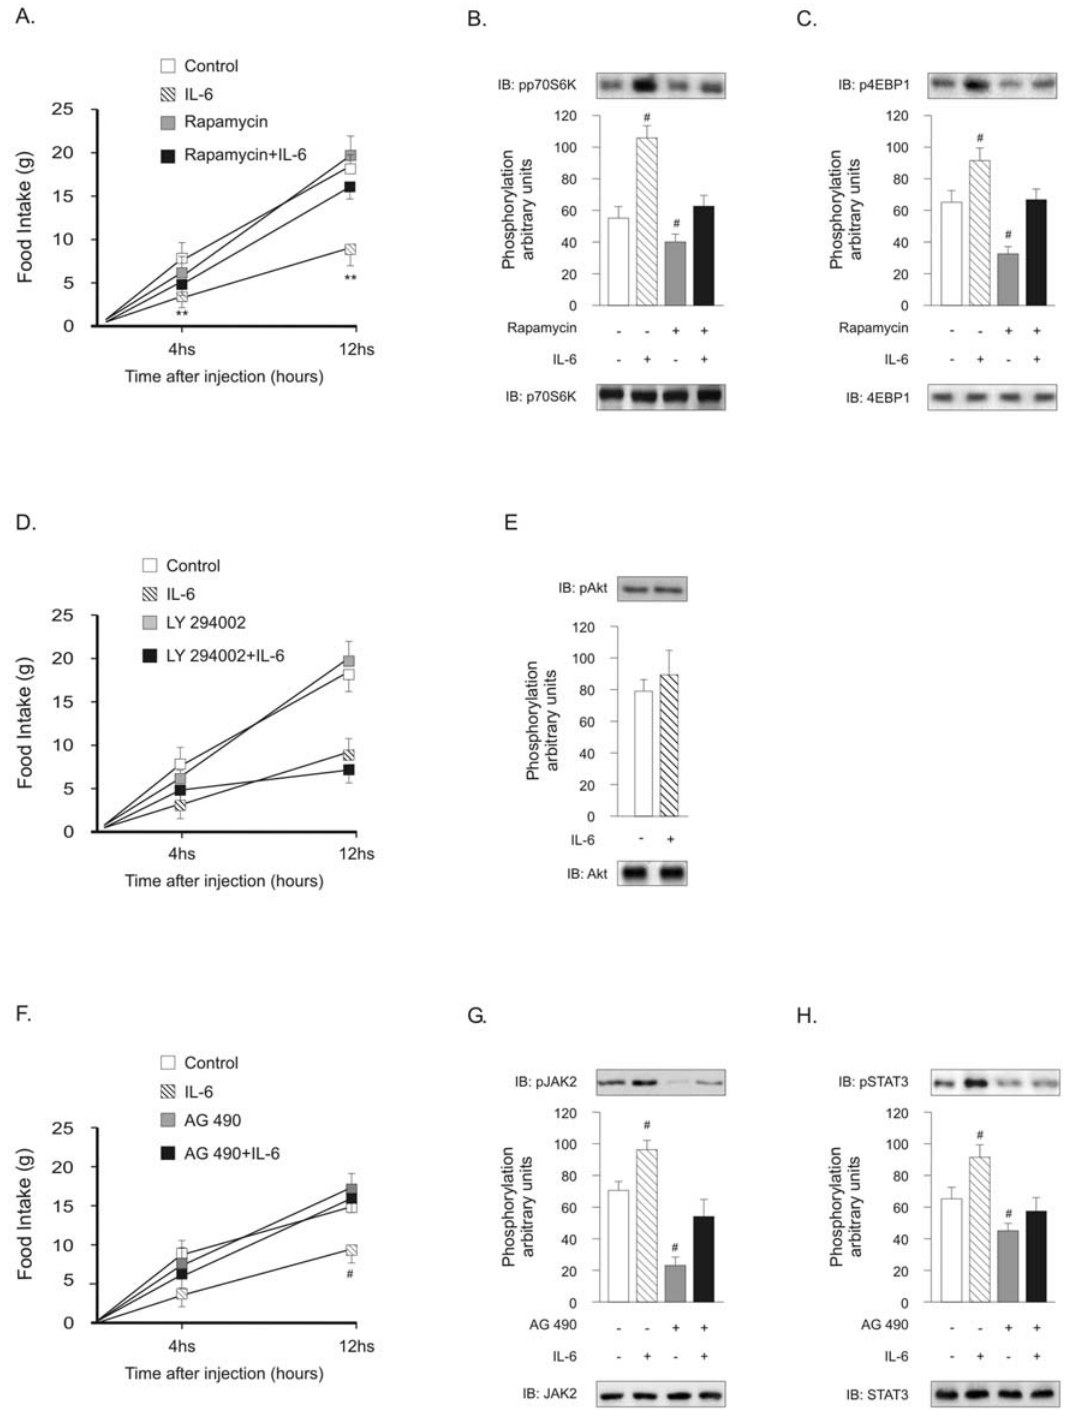
Figure 2. Effects of IL-6 on food intake and hypothalamic PI(3)K/mTOR and JAK/STAT activity. (a) Pretreatment with Rapamycin blocks IL-6-induced anorexia ( n =10–12 animals per group). (b, c) Representative Western blots of four independent experiments showing hypothalamic lysates from Wistar rats. Phospho-p70S6Kinase thr389 , threonine phosphorylated p70S6Kinase and total p70S6K (b); phospho-4EBP1 thr70 , threonine phosphorylated 4EBP1 and total 4EBP1 (c). (d) Pretreatment with LY294002 had no effect on anorectic response to IL-6 ( n =10–12). (e) Representative western blot of four independent experiments showing hypothalamic lysates from Wistar rats. Phospho-Akt ser473 , serine phosphorylated Akt and total Akt. (f) Pretreatment with AG490 blocks IL-6-induced anorexia ( n =10–12 animals per group). (g, h) Representative Western blots of four independent experiments showing hypothalamic lysates from Wistar rats. Phospho-JAK2, tyrosine phosphorylated JAK2 and total JAK2 (g); phospho-STAT3, Tyrosine phosphorylated STAT3 and total STAT3 (h). Data are the means 6 SEM. ** p , 0.01, vs. control group; # p , 0.05, vs. other groups.